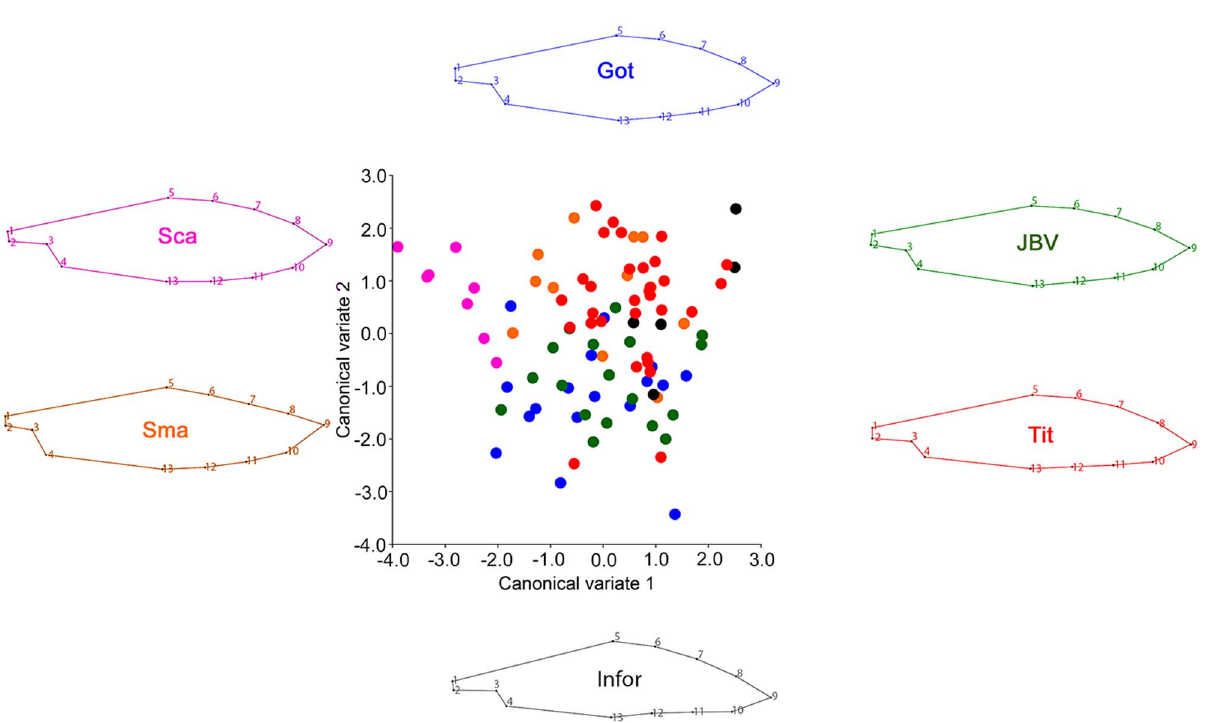
Fig. 4. Canonical variate analysis of the keel comparing the different Sophora toromiro lines and the two out-groups, Goteborg (Got), INFOR, Jardin Botanico Vin˜a (JBV), Titze (Tit), Sophora macrocarpa (Sma), Sophora cassioides (Sca). The wireframe represents the average shape of each one of the analyzed